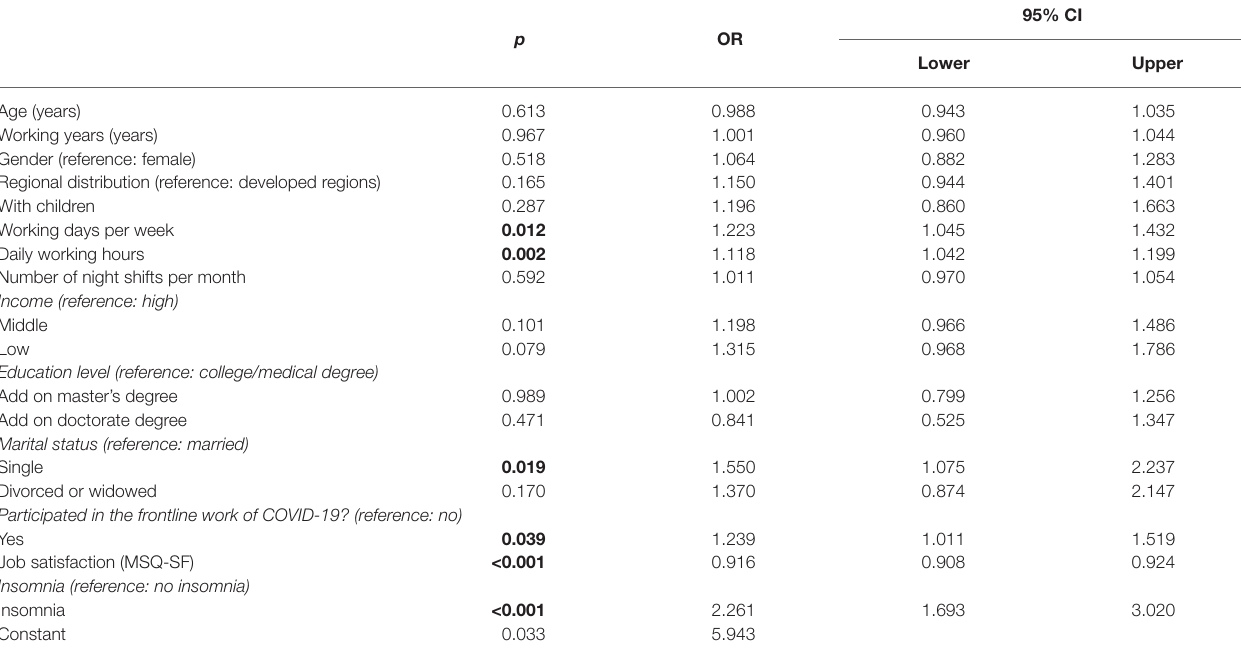
TABLE 3 | Logistic regression analysis of factors associated with turnover intention in